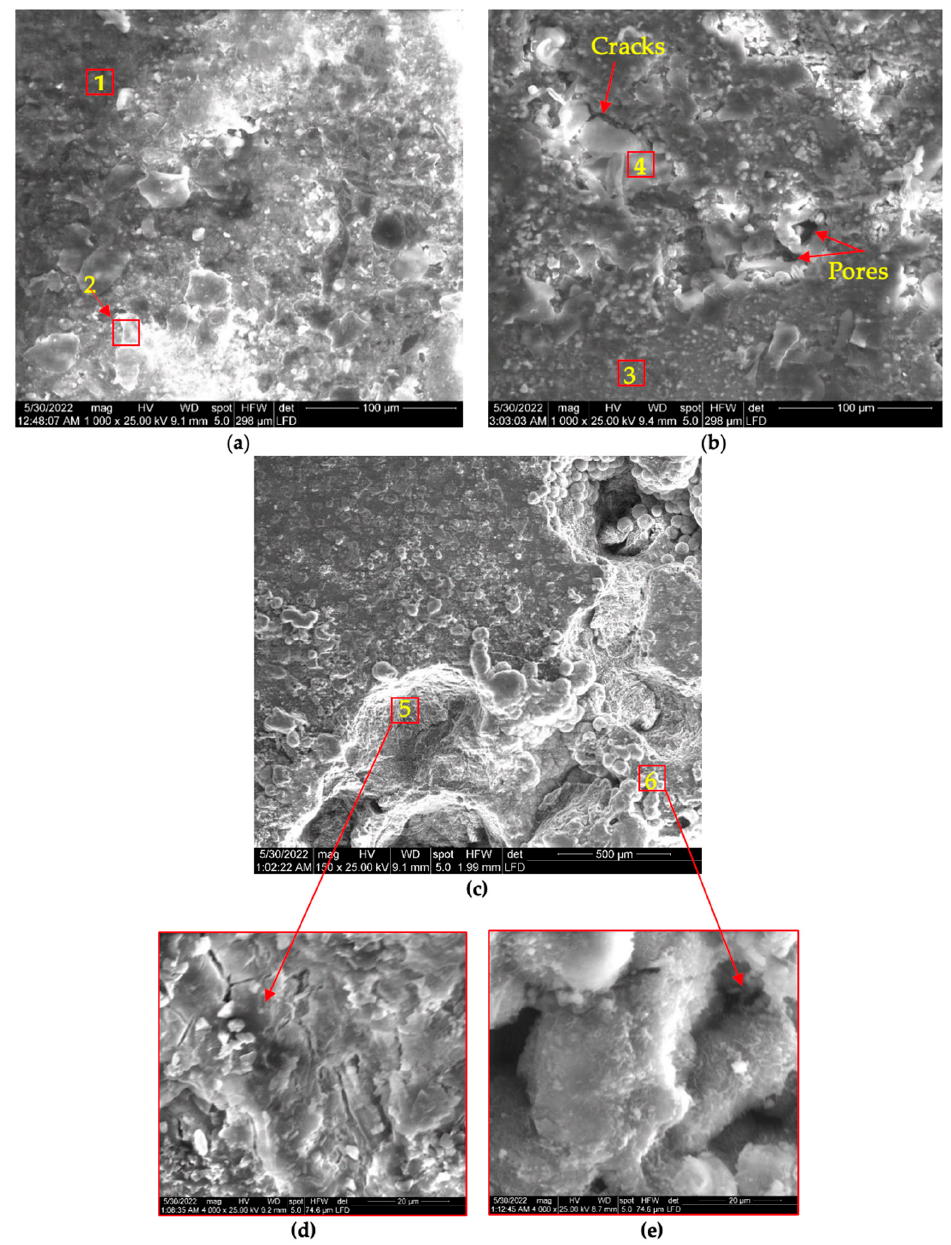
Figure 9. Corroded surface morphology (after 720 h of immersion in SBF) of: ( a ) pure Zn; ( b ) Zn-1.89Mg; ( c ) coated Zn-1.89Mg; and ( d , e ) are higher magnification for rectangles in ( c )—note the different scale bars for better representation of the surface features. Numbers give indications for the different phases present, EDX analysis in Table S3.